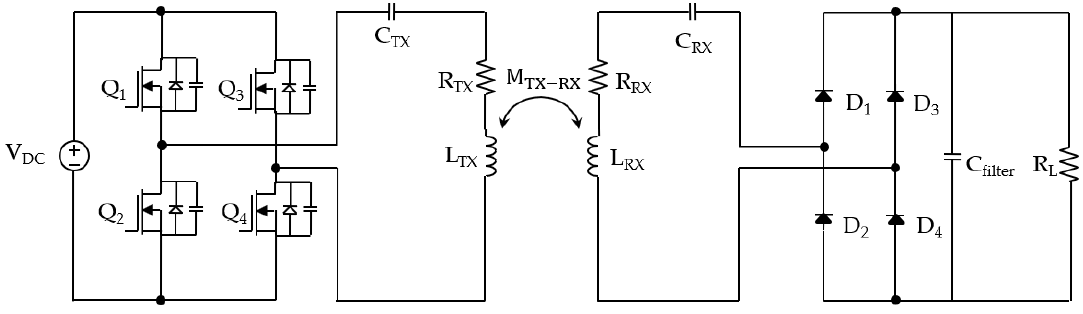
Figure 12. Setup for circuit simulation.